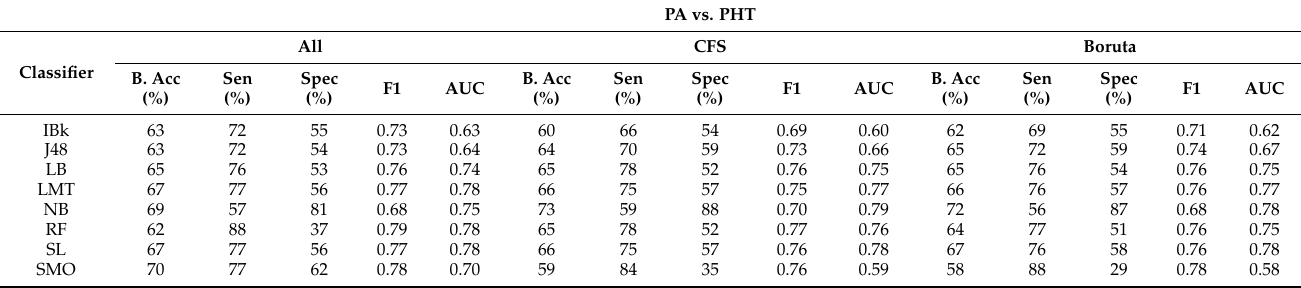
Table A5. Mean balanced accuracy, sensitivity, and specificity for PA vs. PHT disease comparison using various classifiers with all features, CFS, and Boruta feature selection